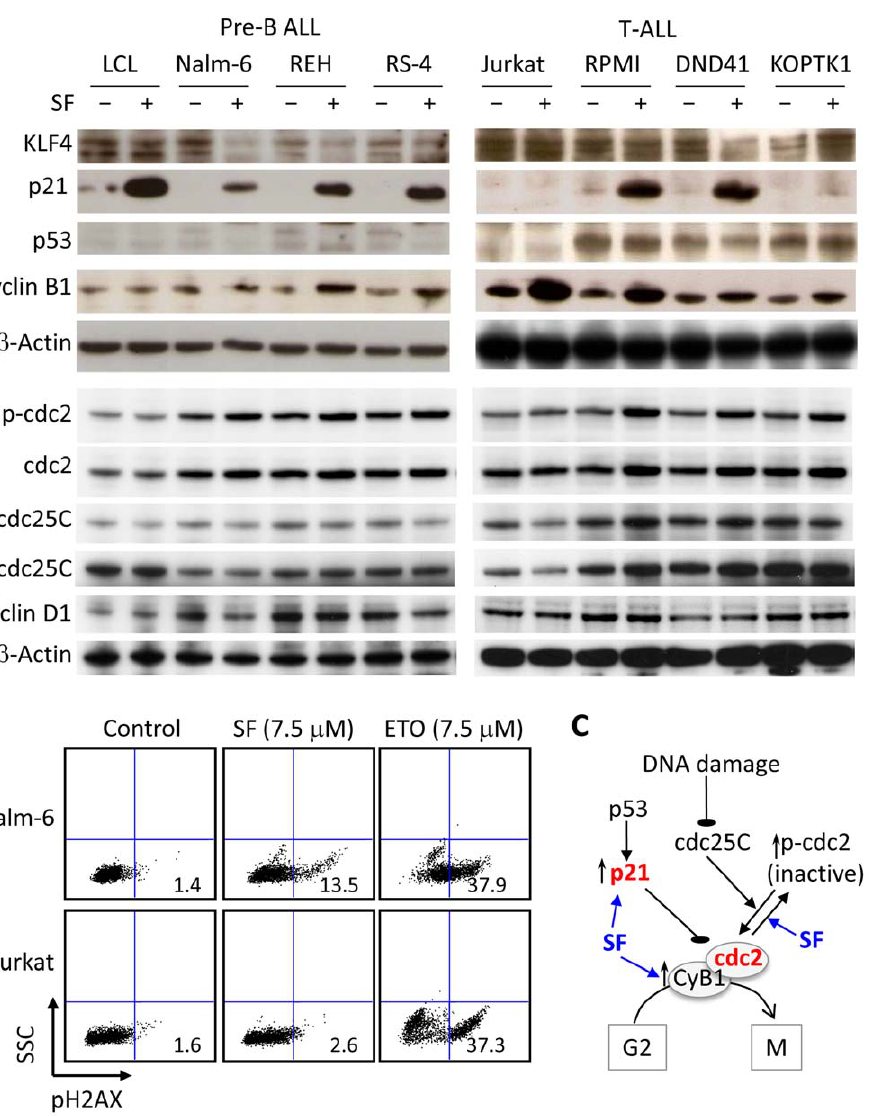
Figure 4. Effect of SF on the levels of total and phosphorylated proteins involved in the G2/M cell cycle arrest. (A) The protein levels of KLF4, p21, p53, cyclin B1, cyclin D1, cdc2, and cdc25C and phosphorylation of cdc2 (Tyr 15) and cdc25C (Ser 216) were evaluated by immunoblots in LCL, pre-B ALL, and T-ALL cell lines incubated with 7.5 m M SF or vehicle for 24 hours. b -actin was used as a loading control. The data are representative of three independent experiments. (B) Detection of phospho-H2AX (pH2AX) in nuclei by flow cytometry in Nalm-6 and Jurkat cells treated with 7.5 m M of SF or Etoposide (ETO) for 24 hours. The data are representative of three independent experiments. (C) Diagram depicting the role of SF in the G2/M cell cycle arrest of ALL